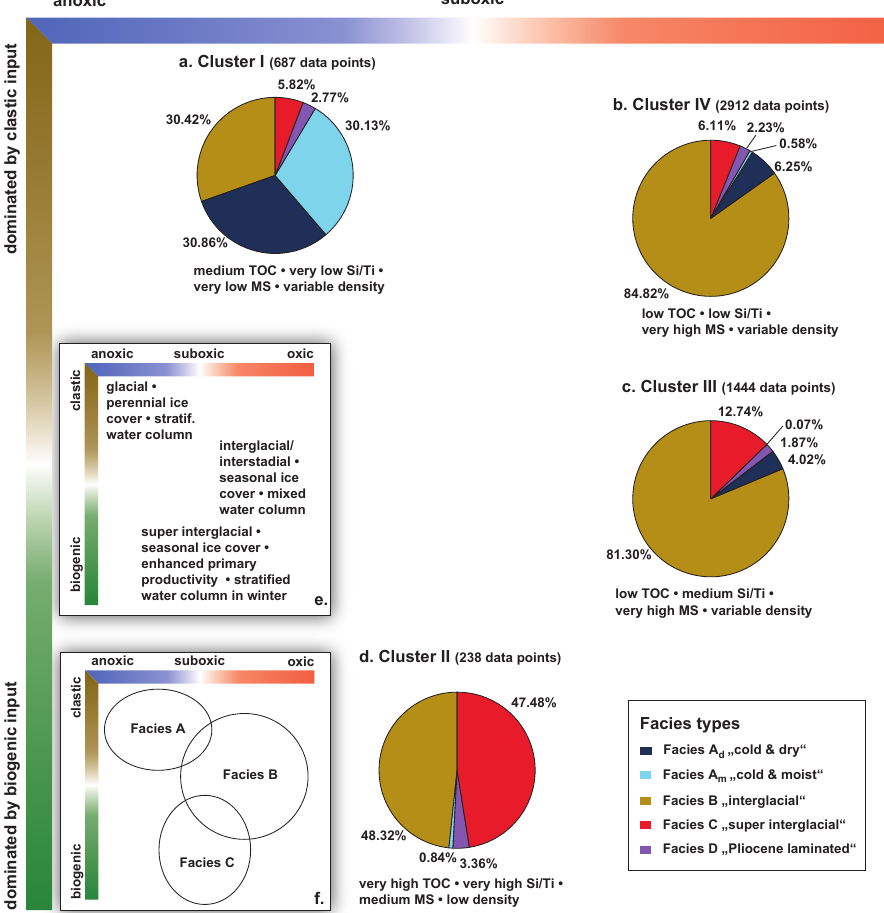
Fig. 6. Pie plots of core-data-derived clusters I to IV versus facies types known from core description. Facies colors correspond to those shown in Figs. 3 and 4. Clusters are distributed according to their redox conditions and clastic vs. biogenic input ratio. (e) shows where different paleoenvironmental conditions would plot in such a redox-condition vs. input-type diagram; (f) shows this for the Melles et al. (2007, 2012) and Brigham-Grette et al. (2013) facies types. Percentages in (a) to (d) are calculated for the facies distribution within each